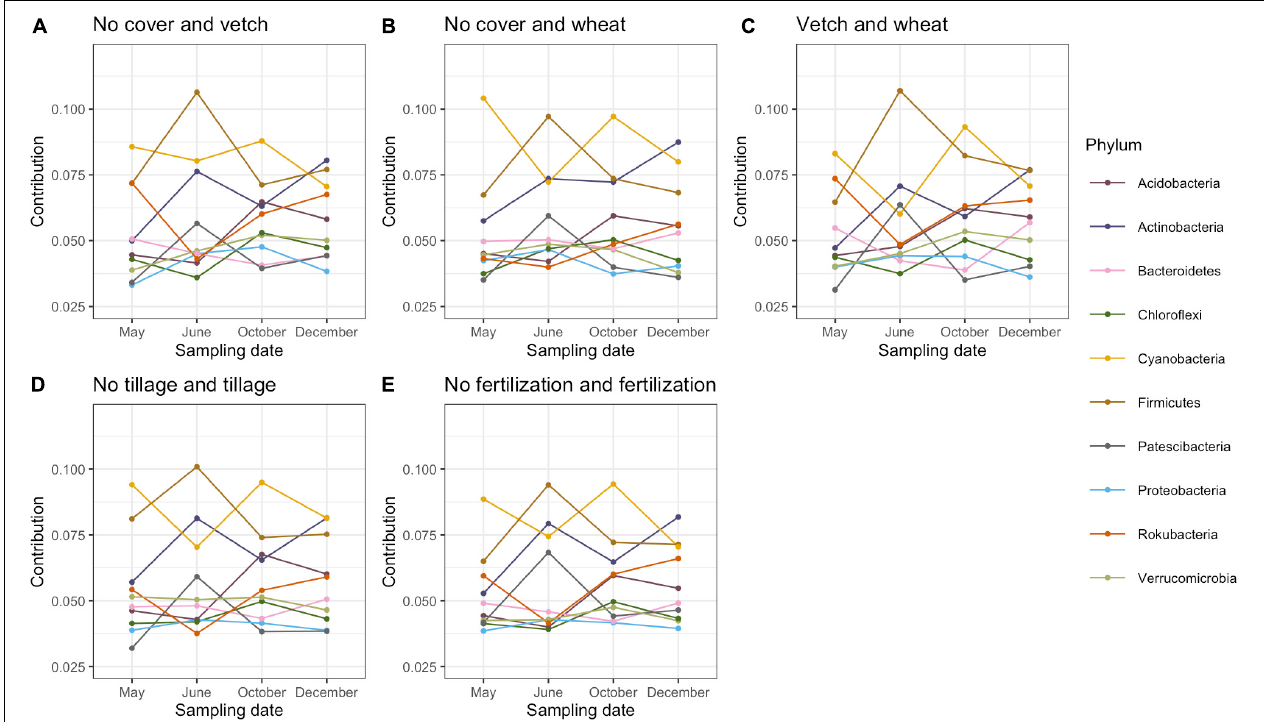
FIGURE 1 | The contribution of bacteria phyla to the total dissimilarity of pairwise comparison among cover cropping (A–C) , tillage (D) , fertilization (E) , and across four seasons based on SIMPER (Analysis of Similarity) analysis.